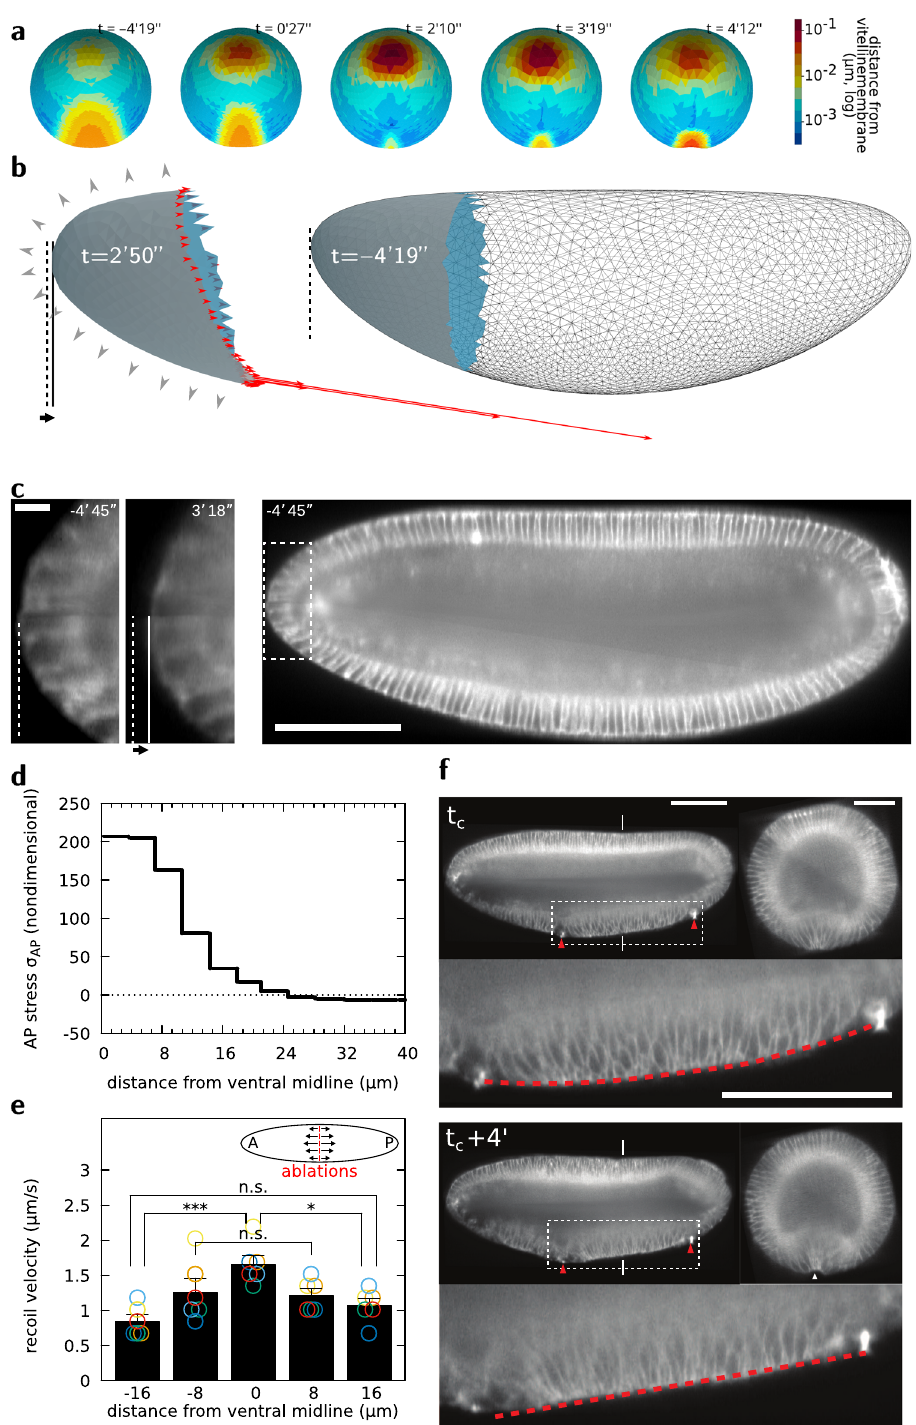
Fig. 5 Embryo poles function as anchoring sites for ventral midline fl attening and furrow formation. a Distance map of the apical surface to the vitelline membrane at different phases of VFF. b Forces exerted on the poles by the rest of the tissue (red arrows), and pressure forces exerted by the incompressible cytoplasms (grey arrowheads), pole tissue deformation (compare shape of solid- fi lled regions) and displacement of the pole (solid and dashed lines) in simulations. c Digital mid-sagittal section showing inward displacement of the pole tissue during VFF. Scale bar 100 μ m, zoom 5 μ m. d Tension distribution at different DV positions from the ventral midline in simulations at t ¼ 0 0 30 00 . e Recoil velocity distribution after DV-oriented IR fs laser ablation at different DV positions from the ventral midline. n = 6 embryos, data are presented as mean values ± standard deviation; the statistical test performed was Kruskal – Wallis test for multiple comparisons, * p ≤ 0.05; *** p ≤ 0.001 and n.s. (not signi fi cant), p > 0.05. f Digital mid-sagittal and cross sections of an embryo on which two cauterizations (red arrowheads), acting as fi xed points, have been performed at the ventral side (tc indicates time of cauterization). The red line indicates tissue straightening along the embryo mid-sagittal section in between the two cauterized regions. Experiment performed and result reproduced 3 times. Scale bar sagittal view 100 μ m. Scale bar cross-section 50 μ